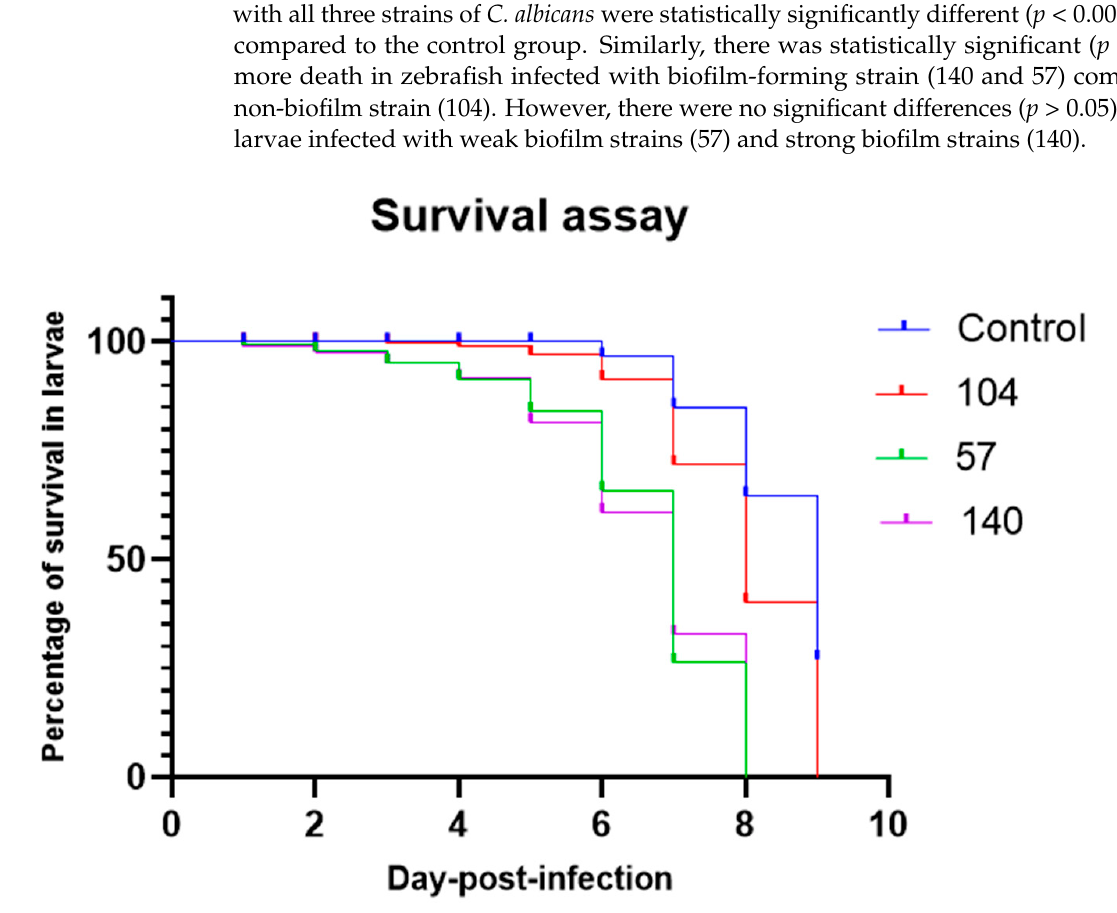
Figure 1. Survival of zebrafish larvae injected with either C. albicans strains 104 (non-biofilm former), 57 (weak biofilm former), or 140 (strong biofilm former). The control group was injected with PBS without an organism. Each experiment was performed in duplicate.